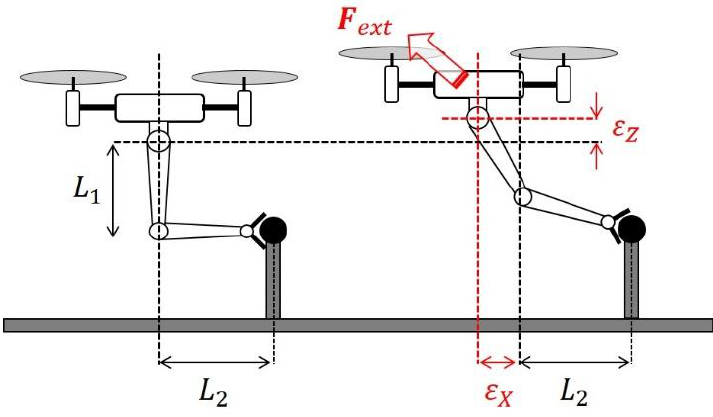
Figure 6. Model considered in grabbing conditions. Nominal operation pose (left), and displacement due to external force (right). The grabbing arm compensates the disturbance exerting a reaction force.